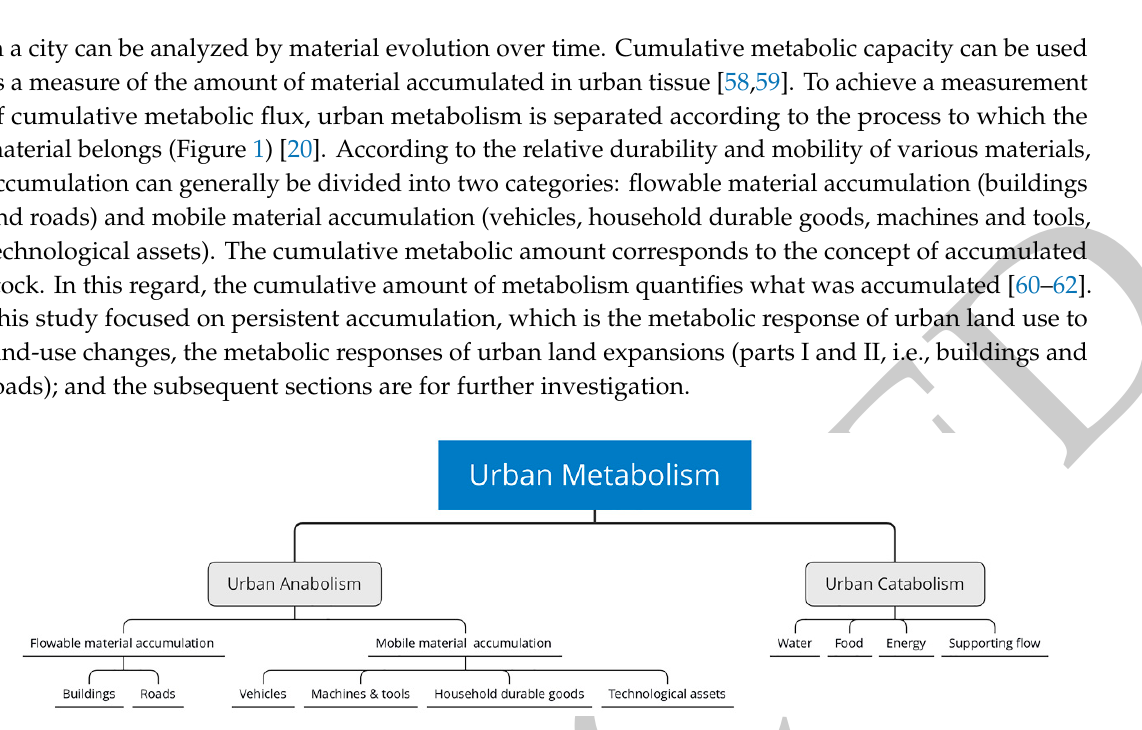
Figure 1. Structure of an urban metabolic account.